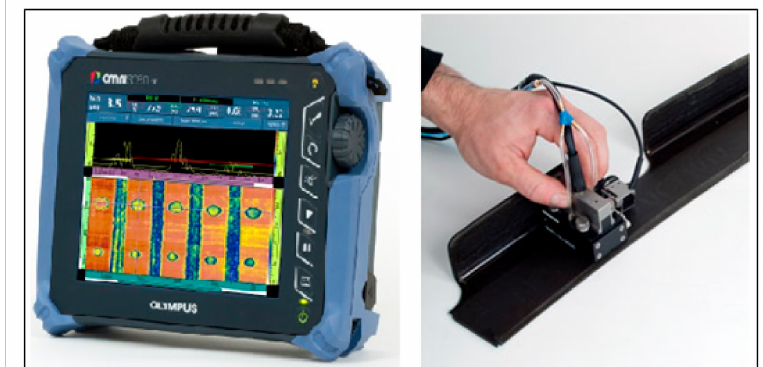
Figure 3. Some details of the ultrasonic (UT) testing